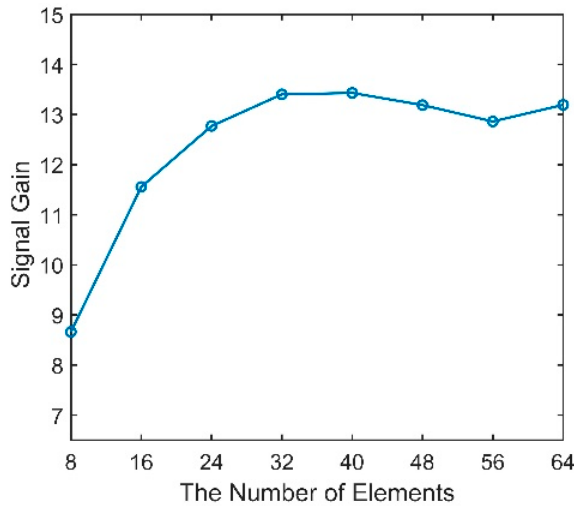
Figure 11. The variation in the SG with increasing numbers of hydrophones.